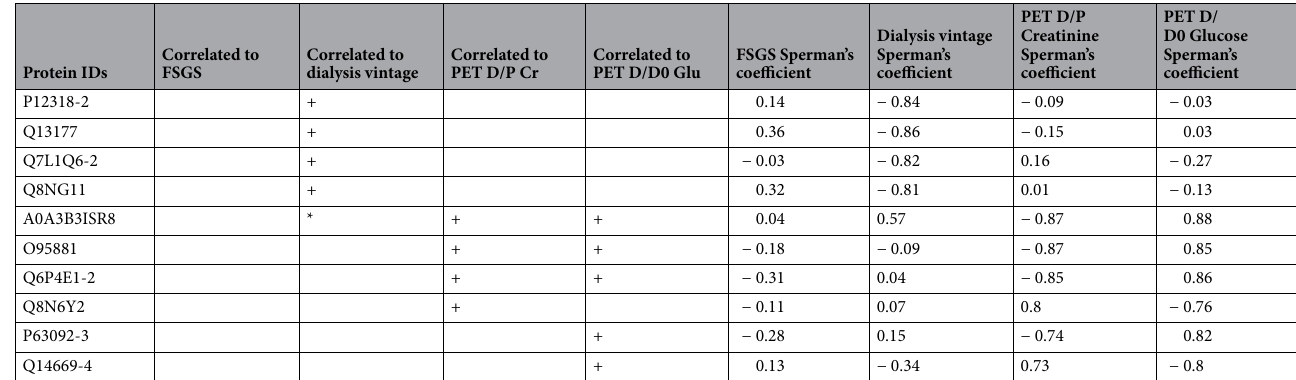
Table 1. List of all highlighted proteins. List of all proteins highlighted by means of Weight Gene Co-expression Network analysis, T -test, Partial Least Square discriminant analysis (PLS-DA) and Support Vector Machine (SVM). The symbol “+” identified the proteins highlighted in each analysis. Proteins Log 2 Fold change and P-values are reported as mean ± standard deviation and − Log 10 respectively. The order of proteins in the table correspond to the rank of priority in the discrimination of FSGS and No FSGS samples using SVM and PLS-DA (see detail in Supplemental Table S1). *Pearman’s coefficient and p value respectively < 0.7 and <